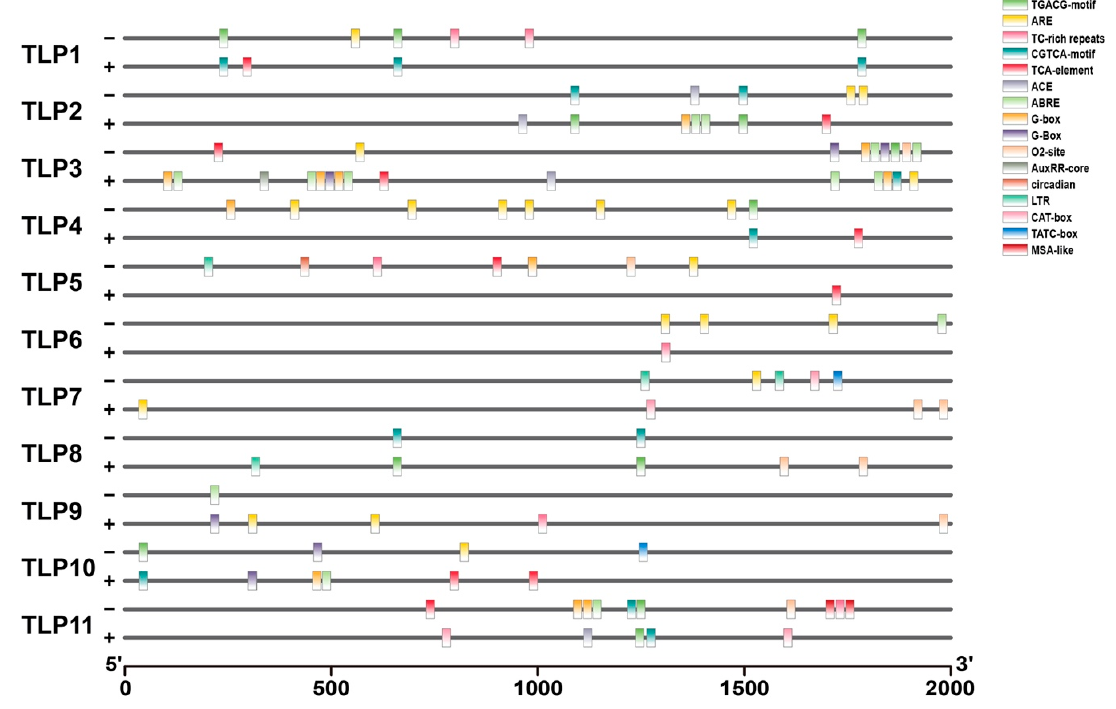
Figure 4. Cis elements in the promoters of SlTLPs.